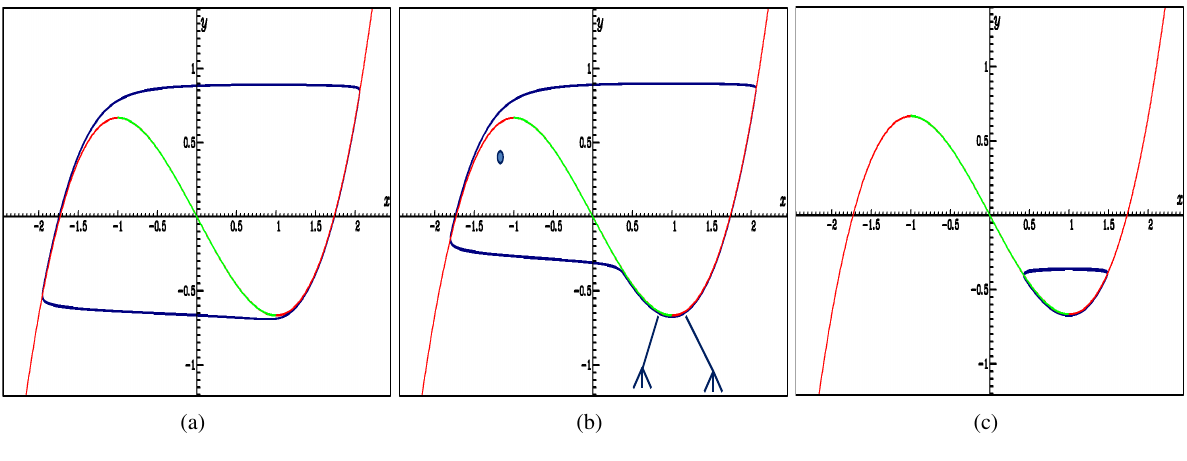
F IGURE 1 Canard explosion of the van der Pol oscillator for ε = 0 . 02 happens in an exponentially small parameter interval near a = a ∗ ≈ 0 . 997461066999 where the transition from relaxation oscillations for (a) a < 0 . 997461066999, to small-amplitude limit cycles for (c) a ≥ 0 . 997461066999, comes via (b) canard